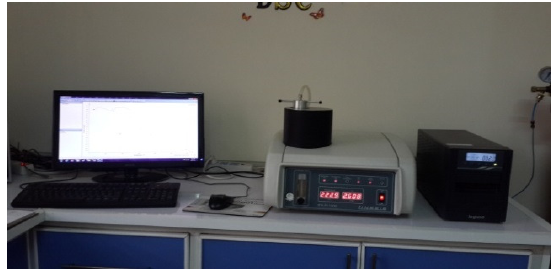
Fig. 11. Differential scanning calorimetry device.